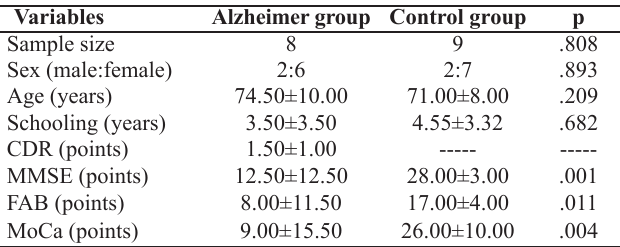
Table 1. Group characterization of the participants. Variables Alzheimer group Control group